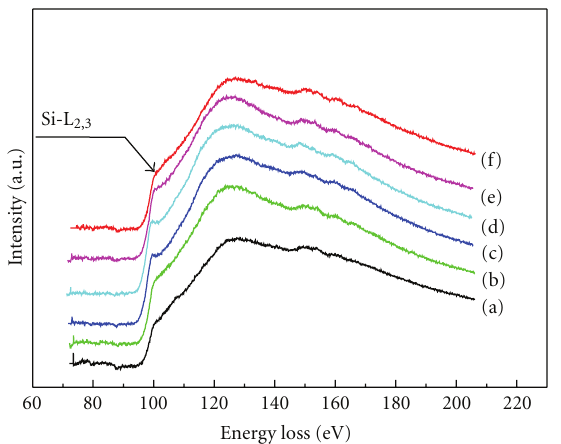
Figure 7: EELS spectra of the nc-Si:H thin films. Spectra (a) ∼ (f) were recorded from positions P 1 ∼ P 6 , in Figure 6.